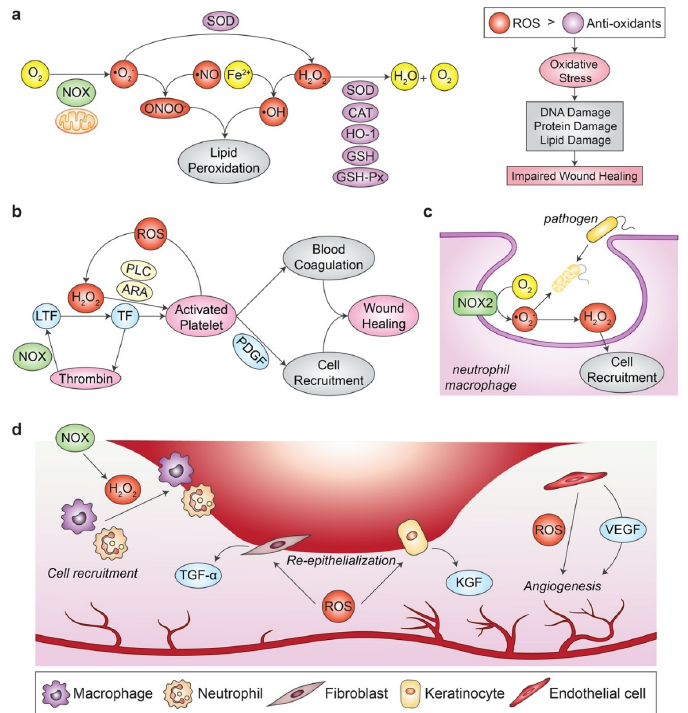
Figure 1. ROS and their role in regulating the process of normal wound healing. ( a ) • O 2 − can be derived from O 2 via the activity of NOX enzyme or the mitochondrial electron transport chain. Next,